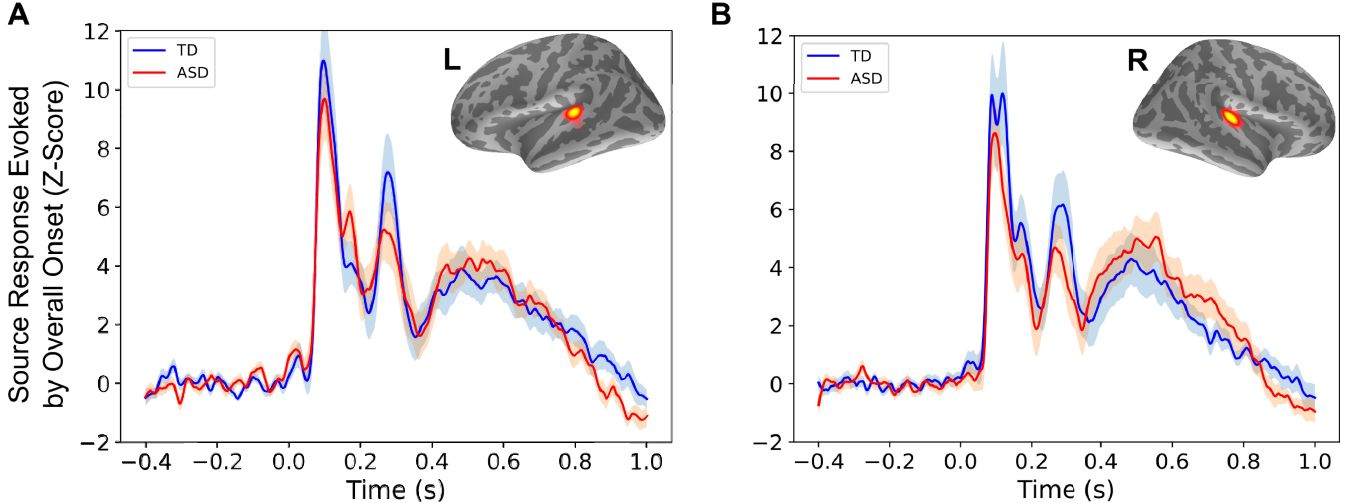
Fig 2. Responses evoked by overall stimulus onset. (A) Averaged left hemisphere evoked responses relative to stimulus onset, in source space, based on individually identified regions of interest (inset), for each group. (B) Same as (A), for the right hemisphere. Shaded areas show standard error per group. Underlying data can be found on Zenodo (doi: 10.5281/zenodo.5823656). ASD, autism spectrum disorder; L, left; R, right; TD, typically developing.